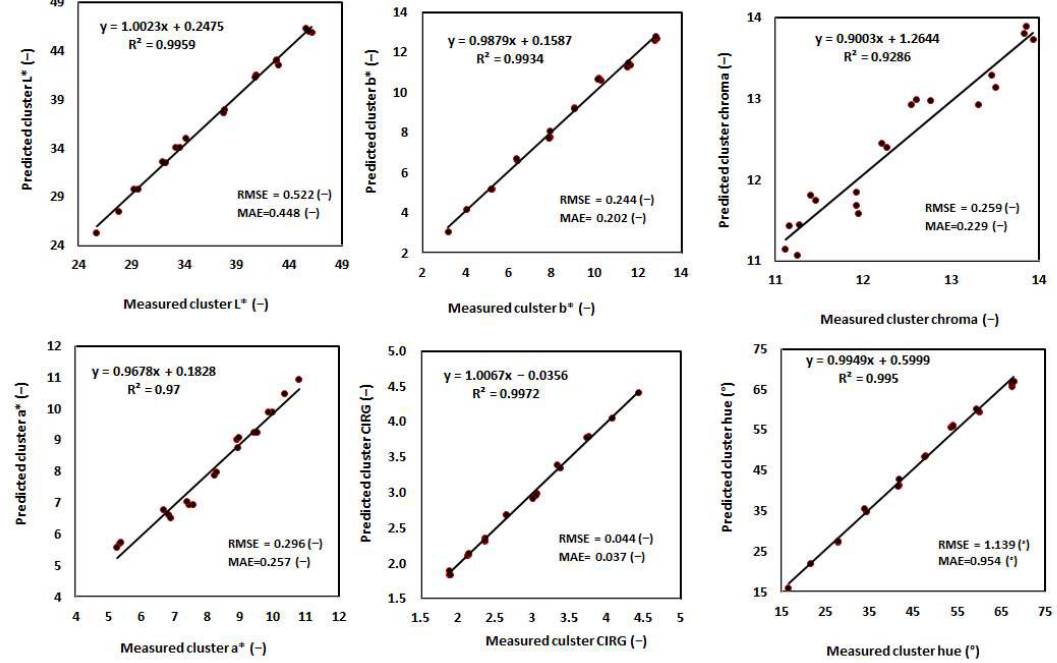
Figure 3. Regression analysis between measured and predicted berries L*,a*, and b*, chroma, hue, and CIRG for the test set. and CIRG for the test